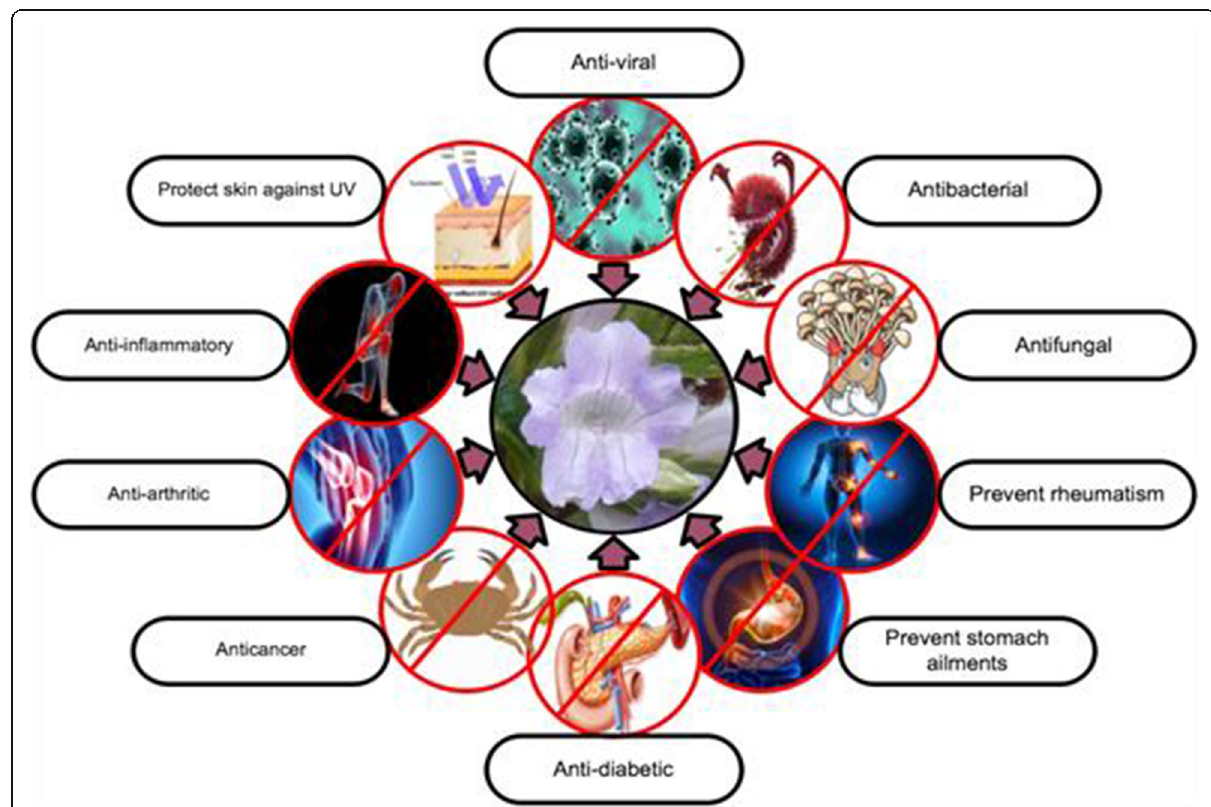
Fig. 3 Diagrammatic presentation of selected pharmacological properties of Neelakurinji (Strobilanthes Kunthianus Nees T Anders) (Source: unpublished photograph of Soumen Bera and Ravi Kiran